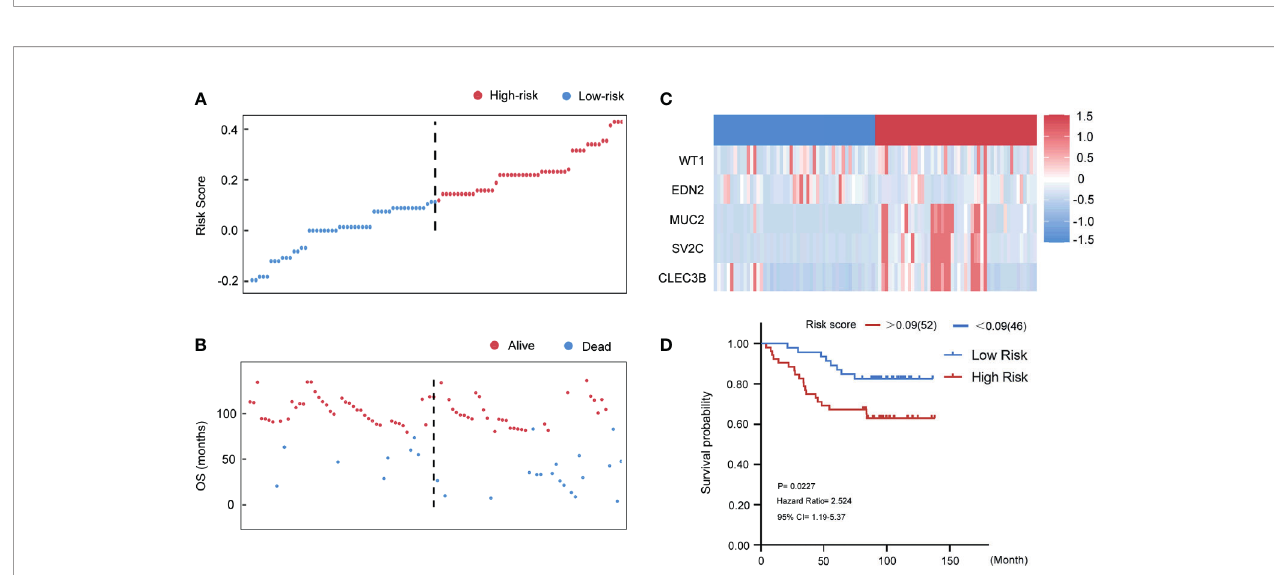
FIGURE 8 | Evaluating the predictive power of fi ve-gene signature in the external validation group. (A) Distribution of risk score. (B) Survival status of breast cancer patients in the external validation group. (C) Heatmap of the prognosis-associated gene expression pro fi les in the Qilu external validation cohort. (D) Kaplan ‐ Meier plot of the high ‐ and low ‐ risk groups in the external validation